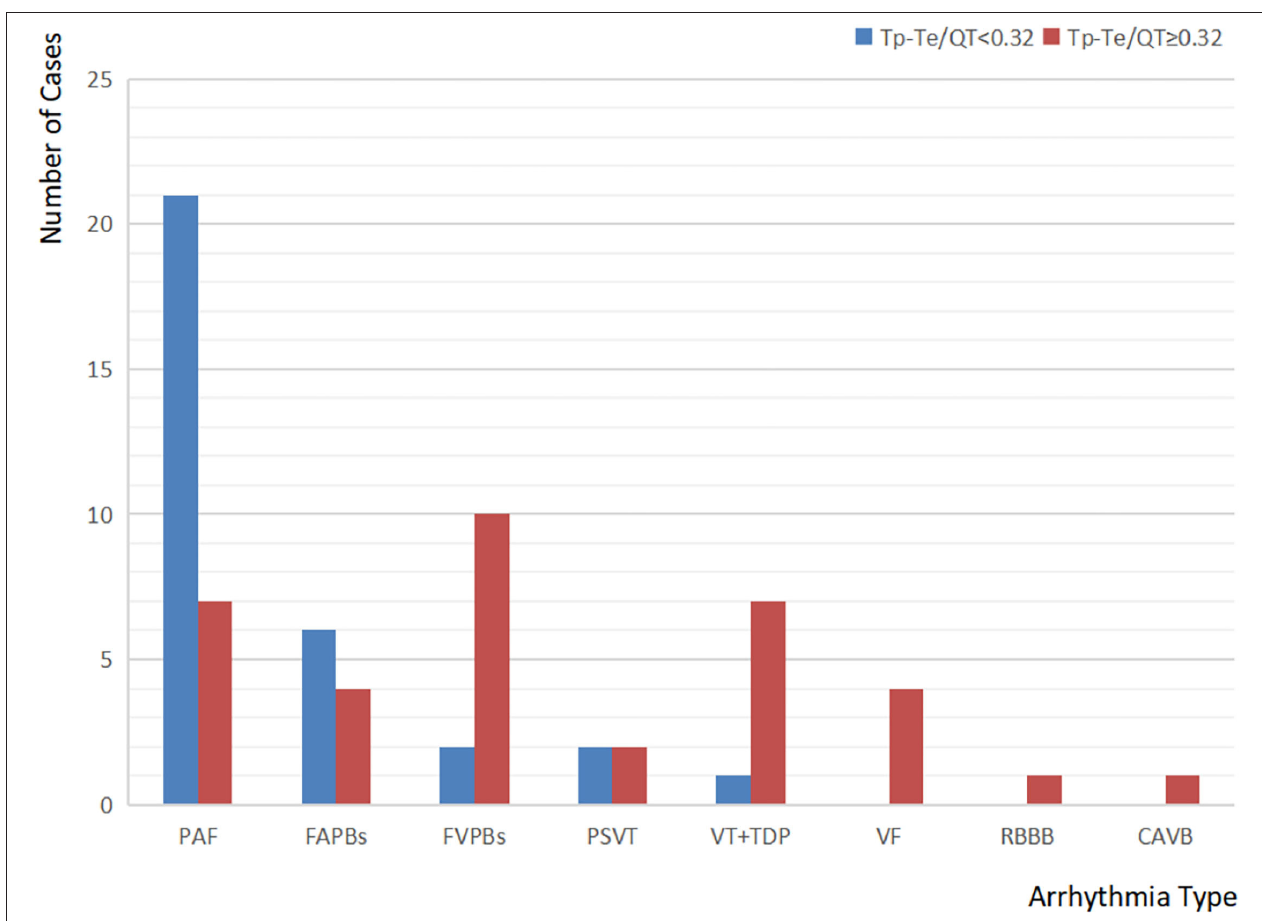
FIGURE 4 | Types of new arrhythmia in patients with sepsis with different